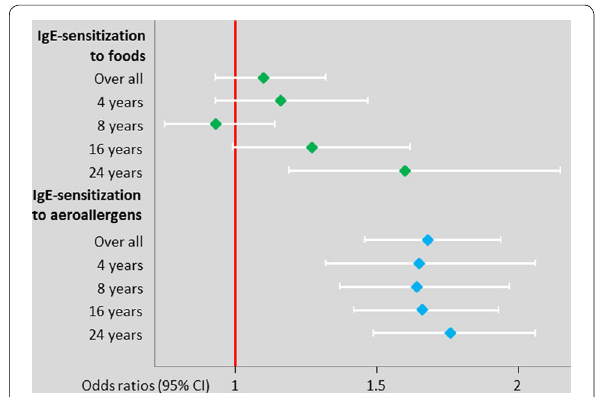
Fig. 4 Impact of male sex on IgE-sensitization up to age 24 years in the BAMSE cohort. GEE analyses include individuals with complete data on IgE-sensitization from at least two follow-ups, 1430 males and 1473 females (reference group)